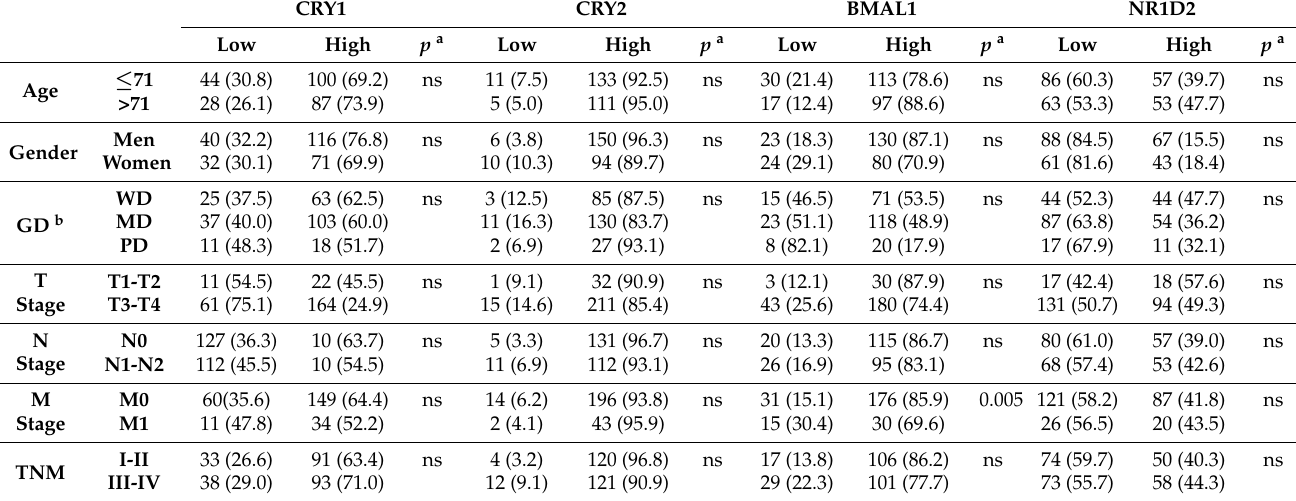
Table 5. Relationship between expression levels of circadian proteins CRY1-2, BMAL1 and NR1D2 and clinicopathologic features of the individuals included in the